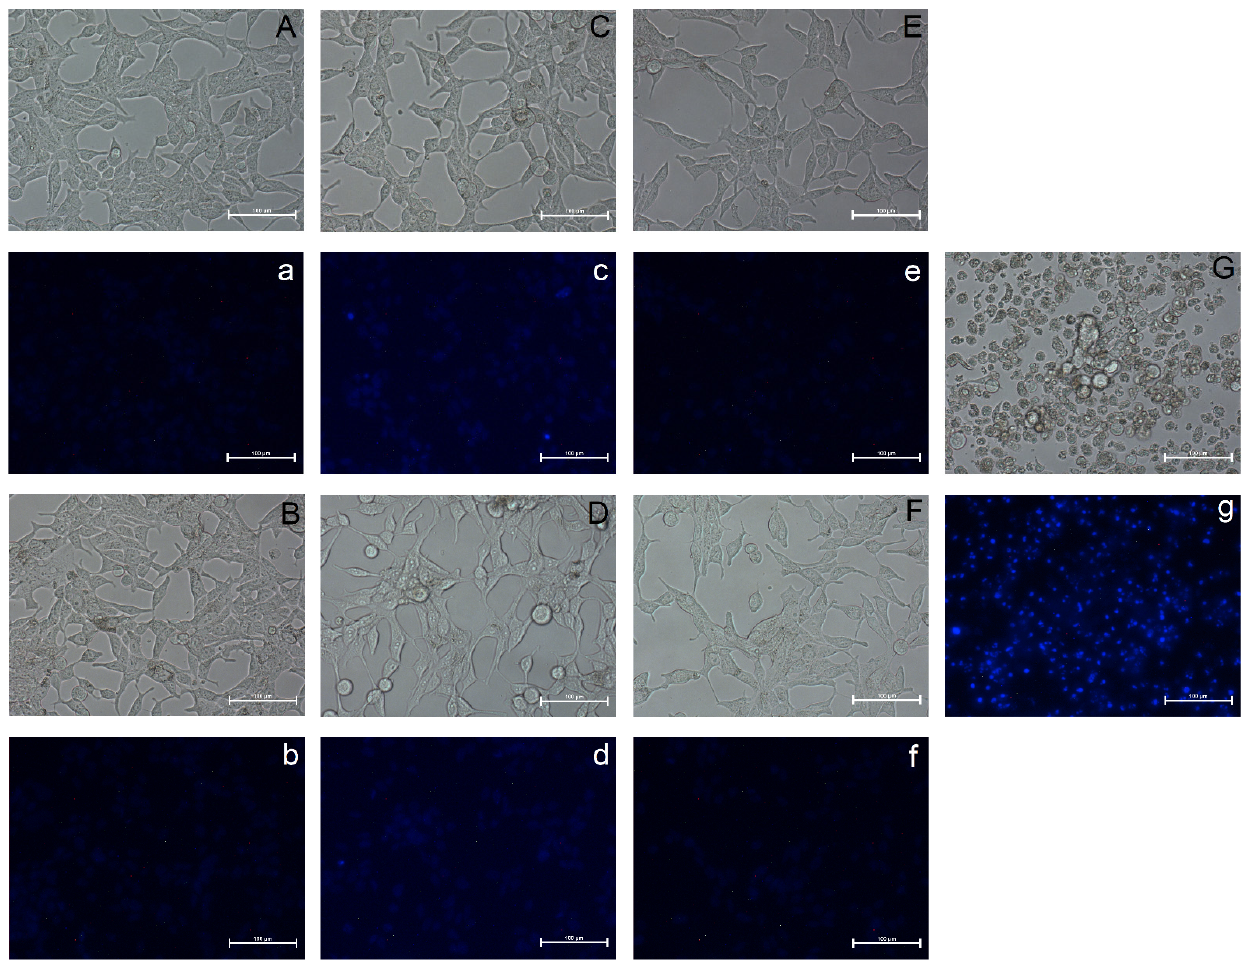
Figure 2. The effect of genistein, selenium and iron on LNCaP cells viability. The representative photographs of LNCaP cells: control ( A , a ), treated with genistein ( B , b ), selenium ( C , c ), iron ( E , e ) and combinations of genistein with Se ( D , d ) and Fe ( F , f ). The cells treated with 2 µM camptothecin ( G , g ) were positive control. Scale bar–100 µm. Photographs marked with uppercase letters present cells morphology. Photographs marked with lowercase letters show the fluorescence of Hoechst 33,258 stained cells.